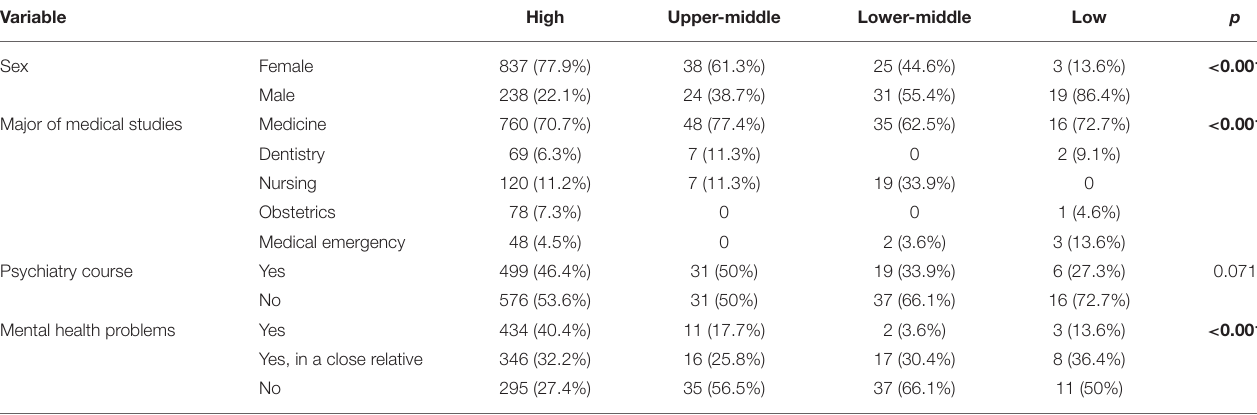
TABLE 2 | Characteristics of the study group considering the HDI index.